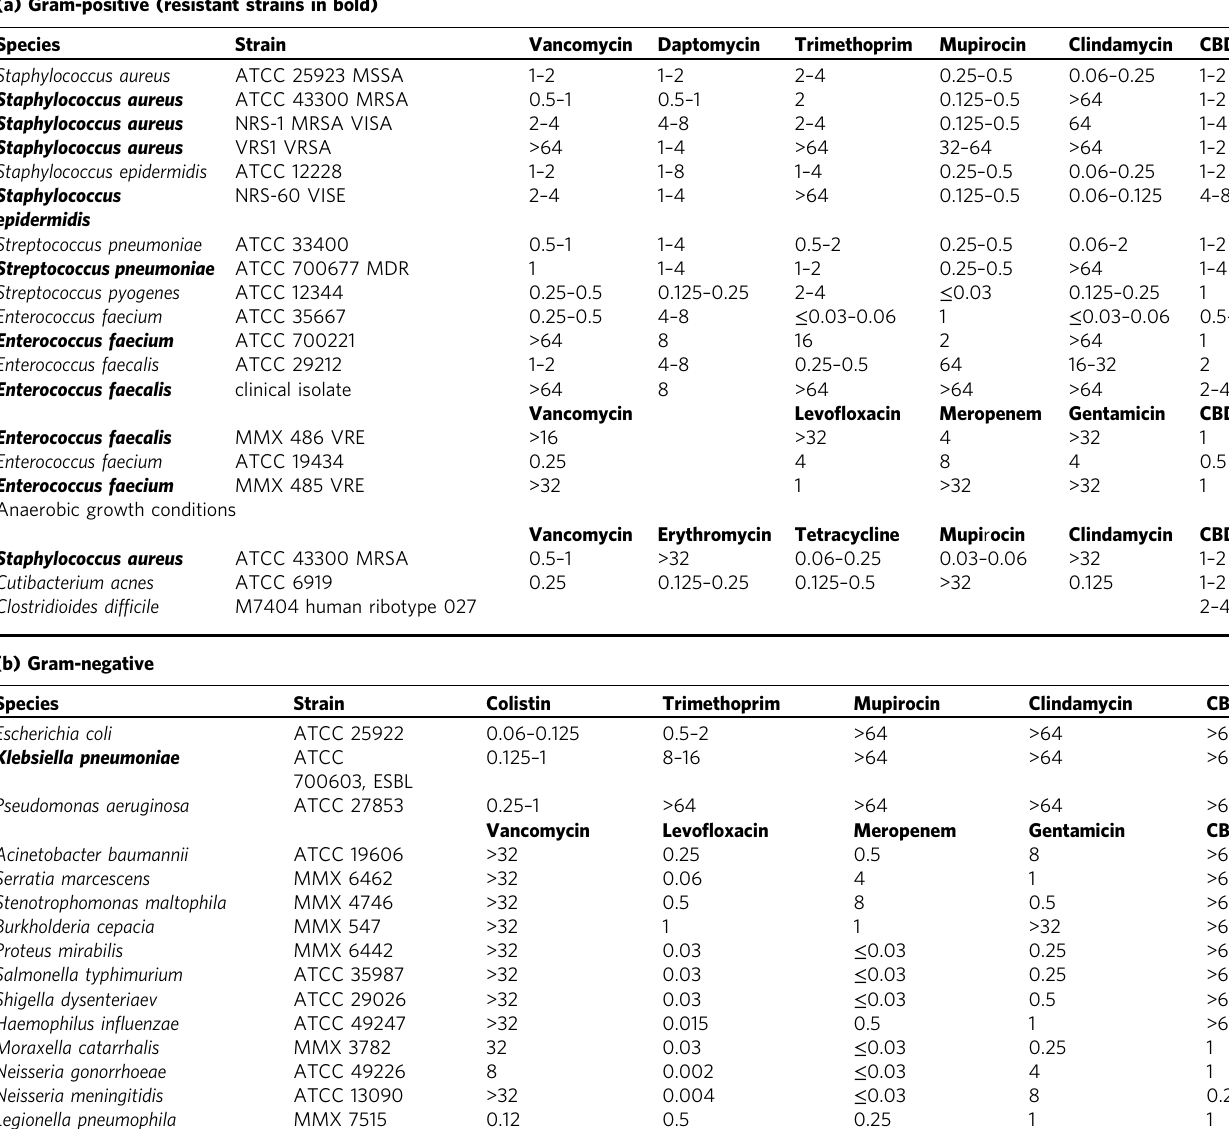
Table 1 Minimum inhibitory concentrations (MICs) of CBD ( μ g mL − 1 ). (a) Gram-positive (resistant strains in bold)